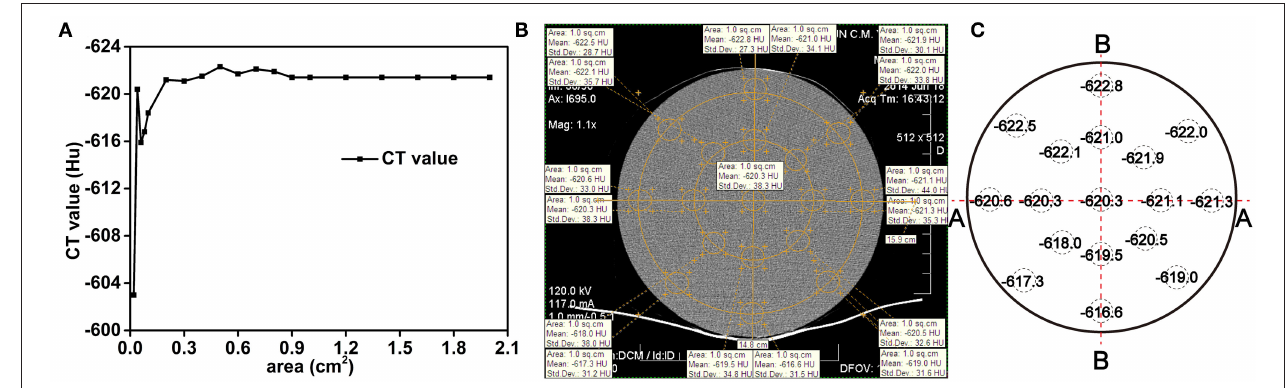
FIGURE 3 | (A) The effect of the selection size area on the fluctuation of the CT values for a pure and uniform Li ingot. (B) Sampling method for CT scanning, (C) The CT values.